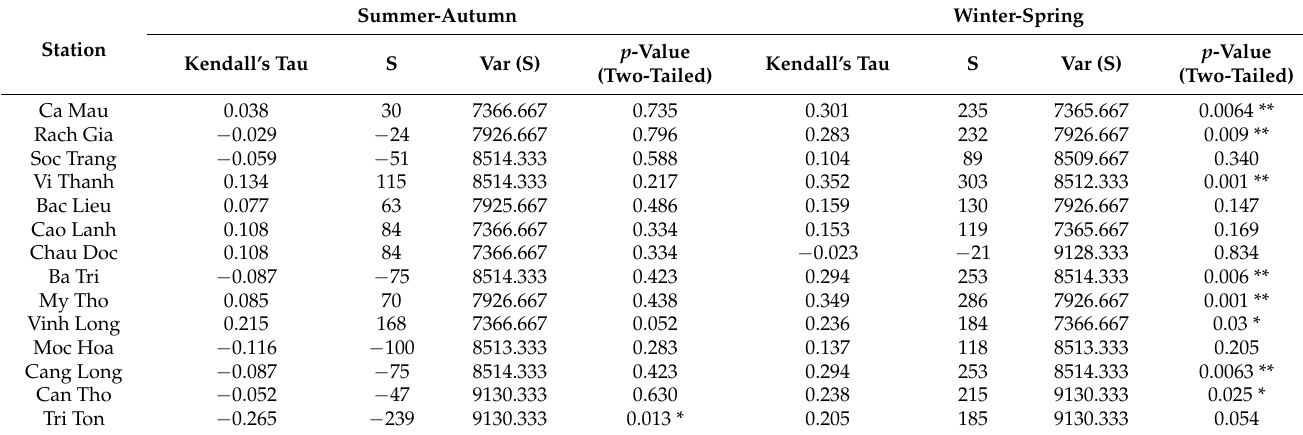
Table A1. Mann-Kendall test trend for rice cropping SPI seasons.